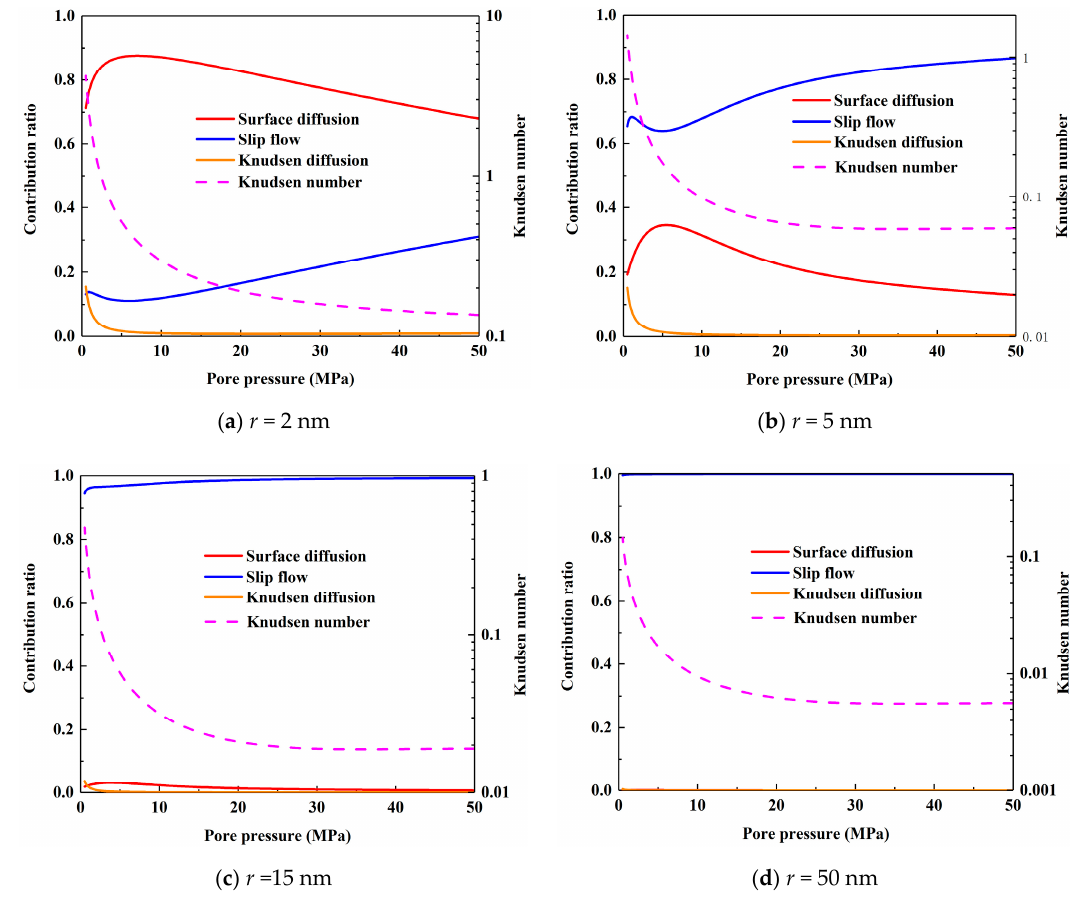
Figure 7. The contribution of multiple mechanisms in organic matrix (ORM) with diverse pore